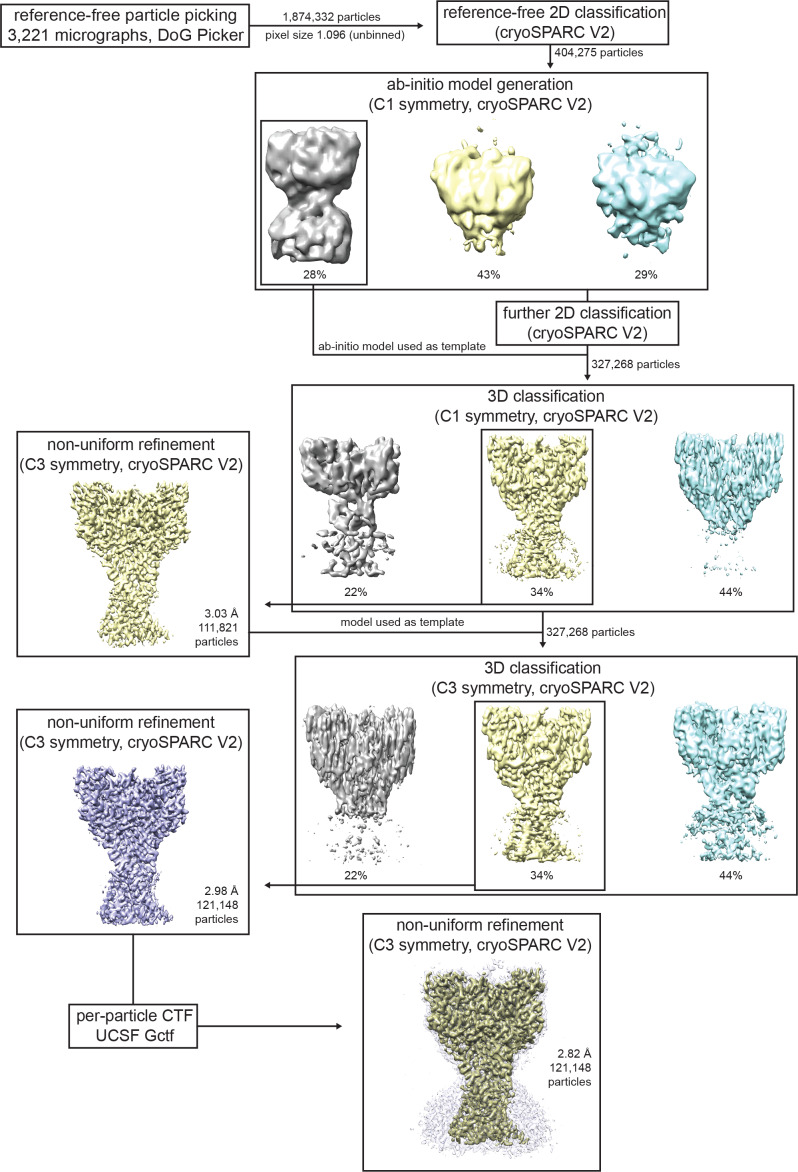
Cryo-EM data processing for cASIC1-SMA at pH 7.0.Data processing strategy for cASIC1-SMA pH 7.0 dataset.